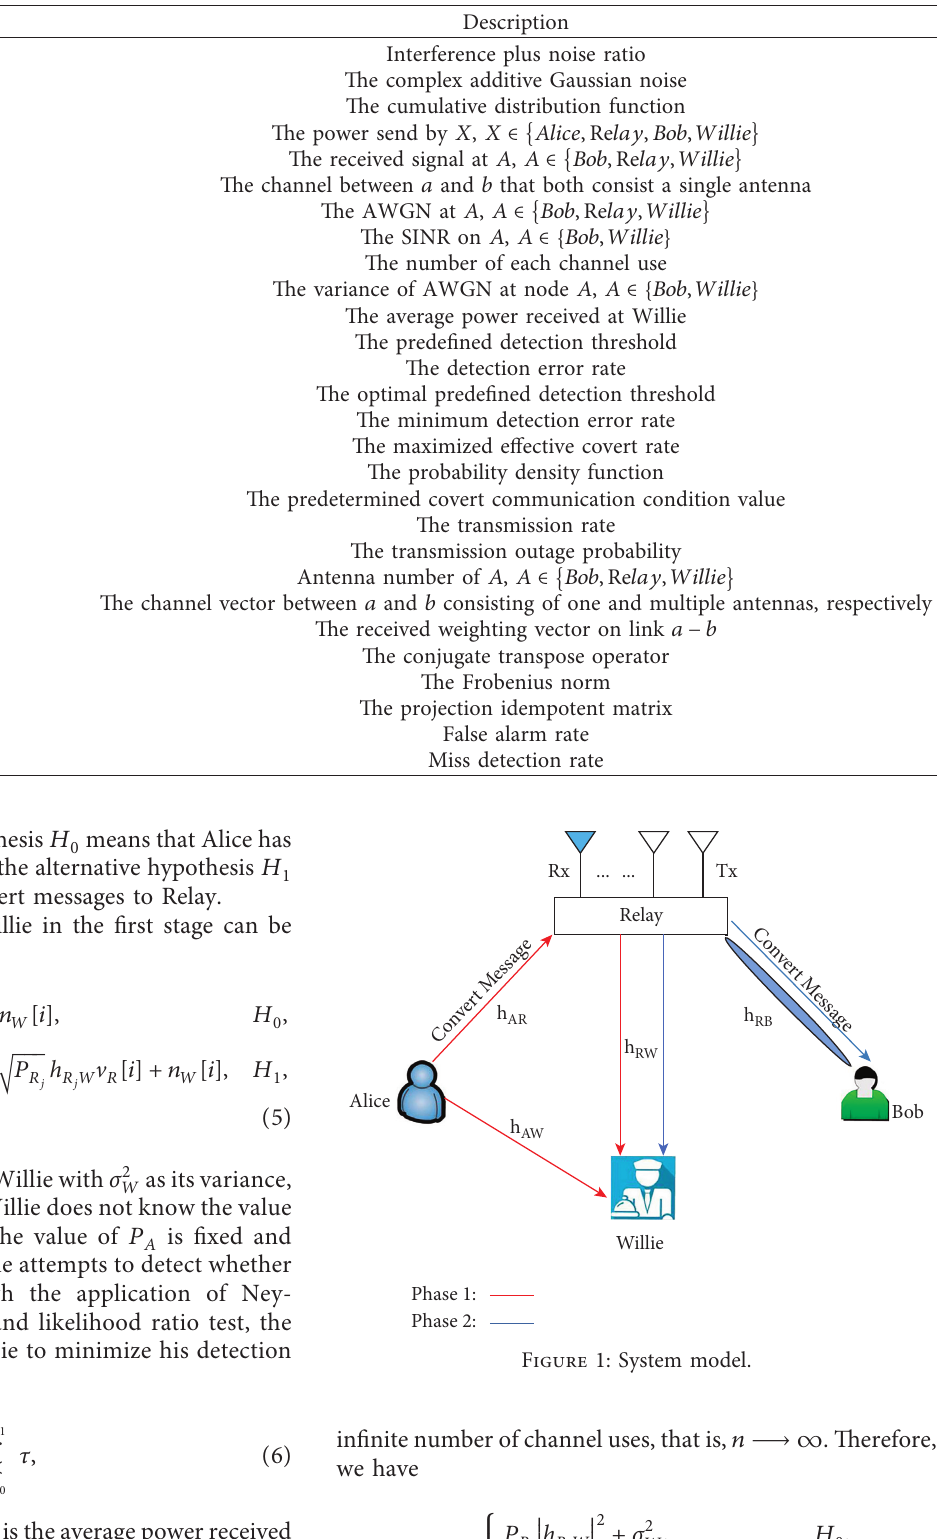
Table 1: List of fundamental variables.